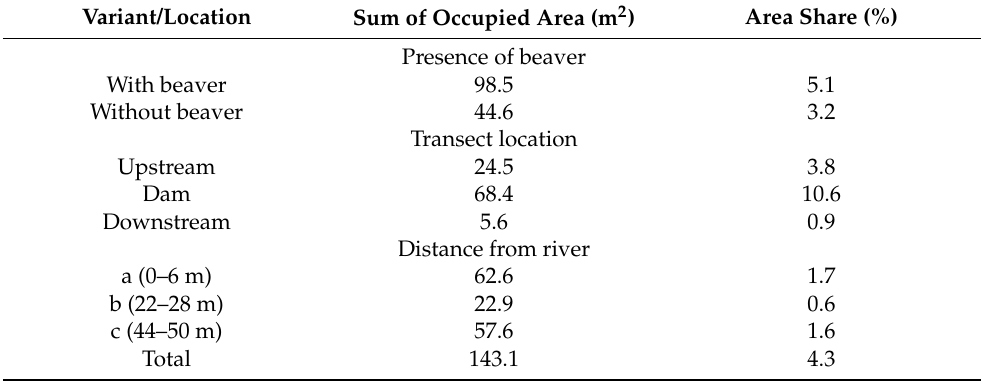
Table 5. Area and percentage of area occupied by alien species in relation to proximity to beaver